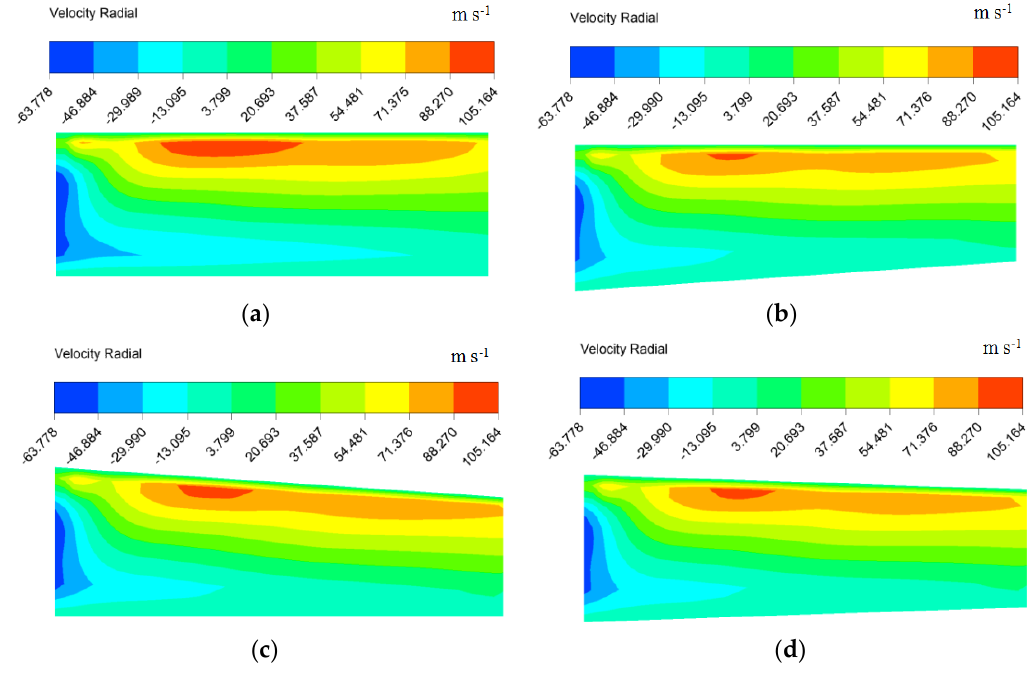
Figure 7. Radial velocity distribution on the meridional surface at 0.6 relative mass flow: ( a ) parallel; ( b ) convergence from shroud; ( c ) convergence from hub; ( d ) equal convergence from shroud and hub.